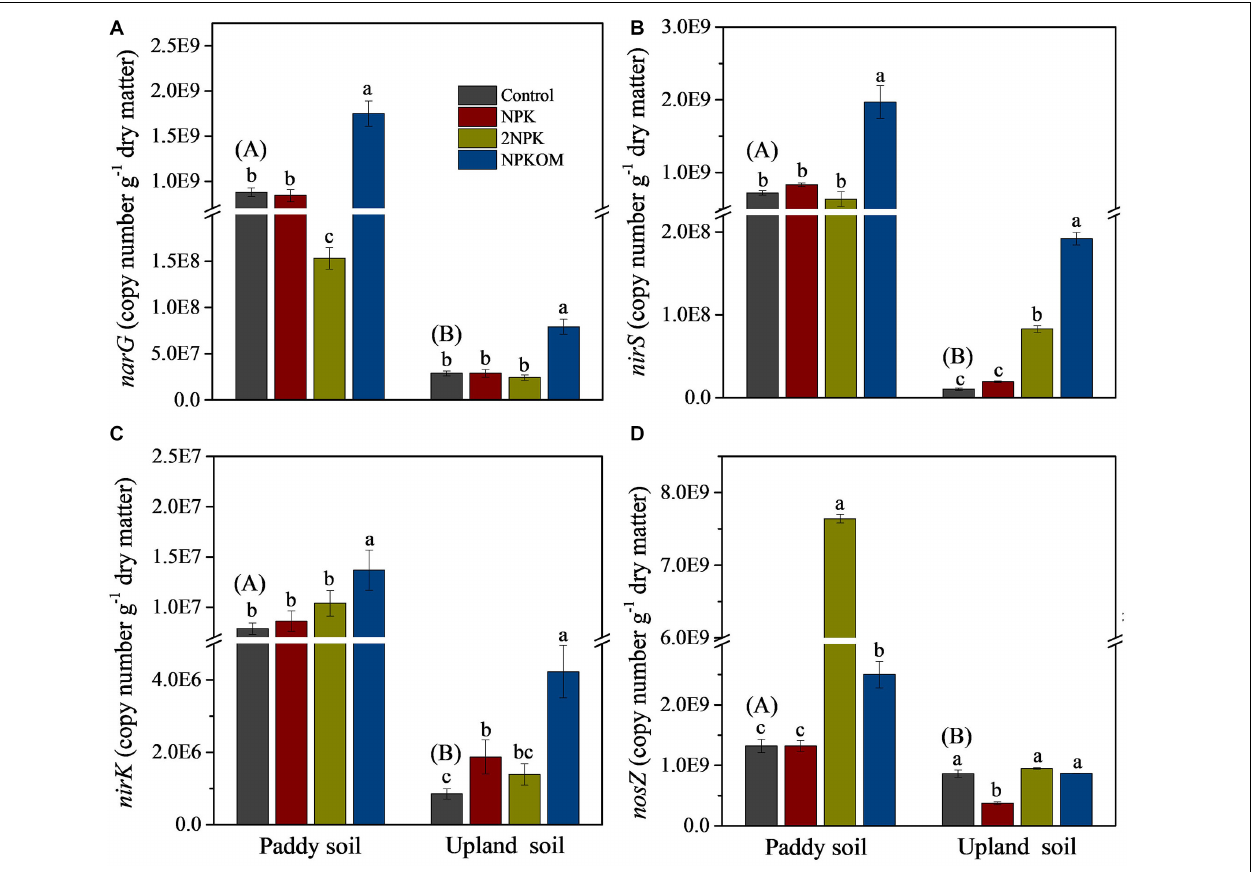
FIGURE 2 | Abundances of narG (A) , nirS (B) , nirK (C) , and nosZ (D) genes among different fertilization regimes. Different uppercase letters in brackets indicate significant differences for the treatment of control between paddy soil and upland soil, and different lowercase letters indicate significant differences among fertilizer treatments for each soil type ( P < 0.05, Duncan multiple-range